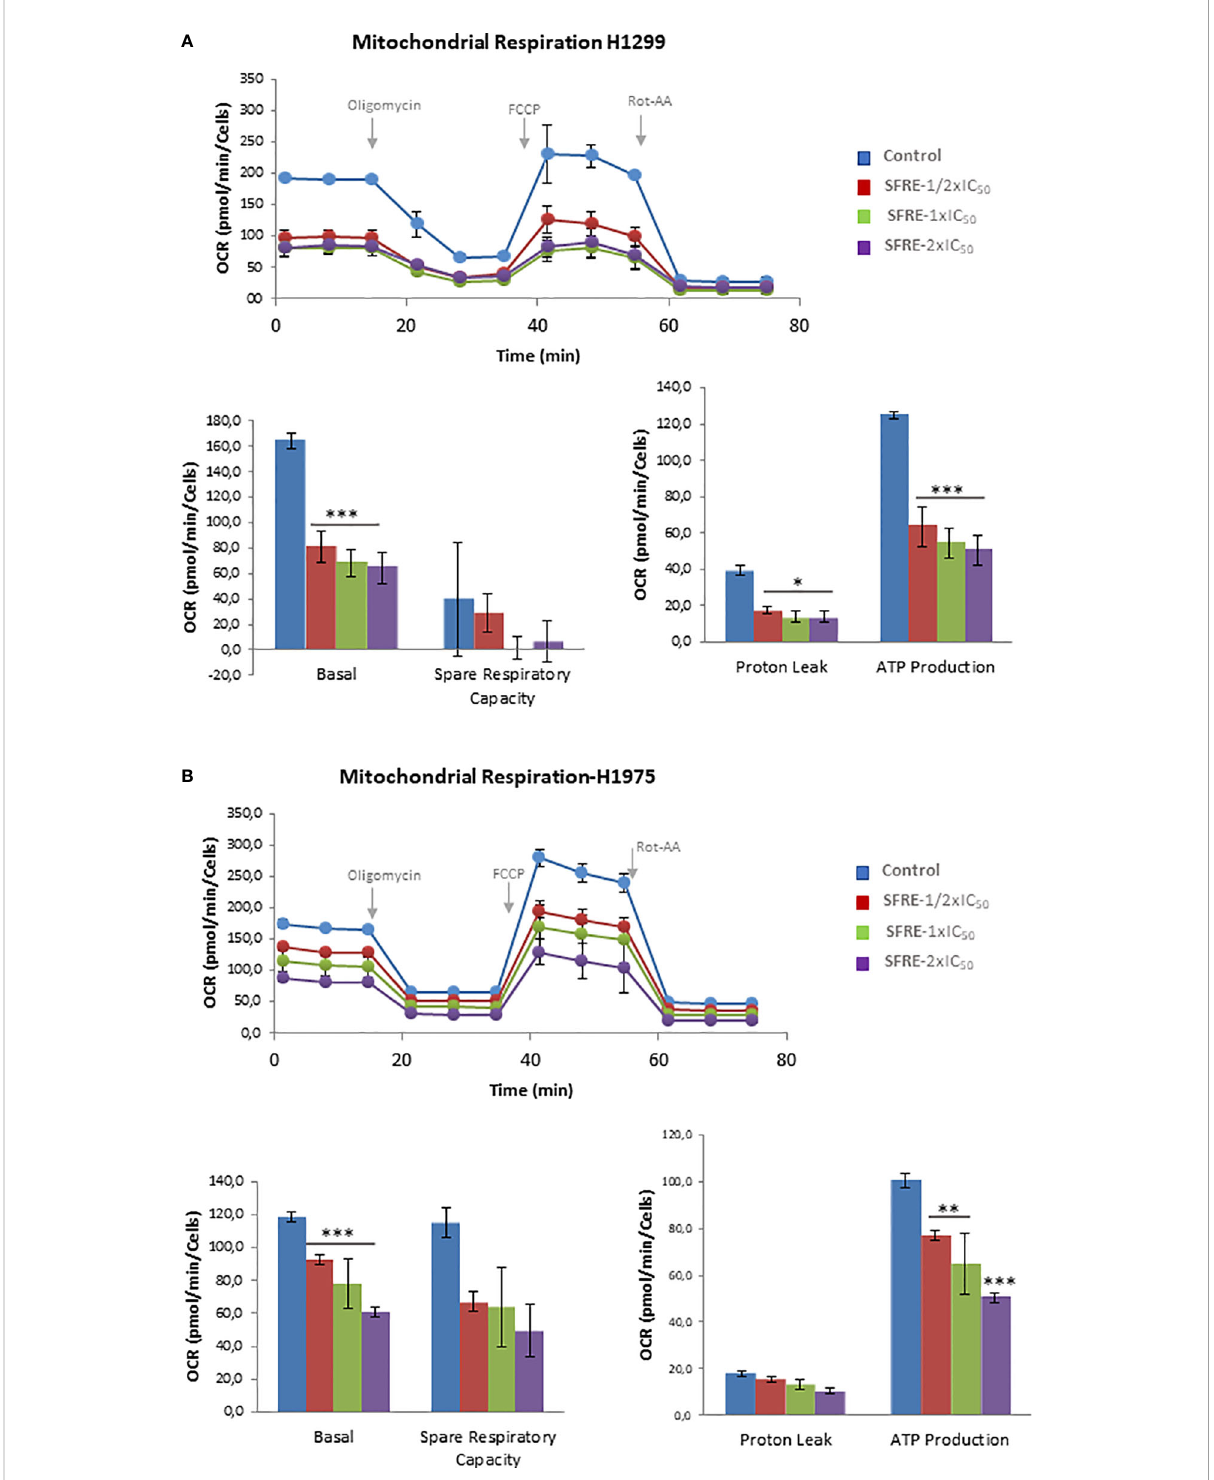
FIGURE 3 SFRE diminishes mitochondrial oxidative phosphorylation. Mitochondrial respiration analysis by fl ux analysis of the oxygen consumption rate (OCR) of H1299 cells (A) and H1975 (B) previously pre-treated with SFRE (1/2xIC 50 , 1xIC 50 and 2xIC 50 ) for 48 h The basal respiration rate, spare respiratory capacity, ATP production, and proton leak of 10,000 cells per condition are compared. Data represent mean ± SEM of three independent experiments, each performed with four to six replicates. Asterisks *, **, *** indicate p values < 0.05, 0.01 and 0.005,